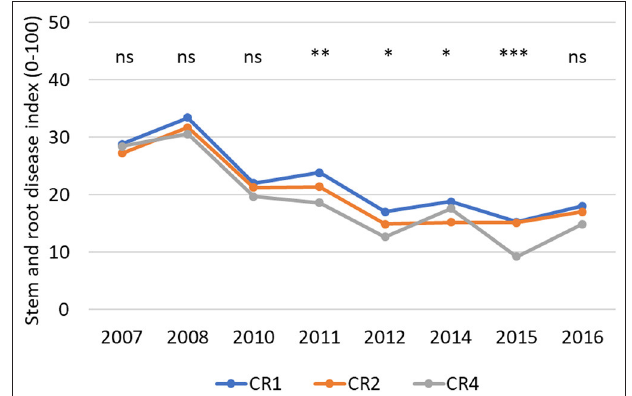
FIGURE 4 | The average stem and root disease index (0–100) in spring wheat in different years and crop rotations. CR1, wheat monoculture; CR2, wheat every 2nd year; CR4, wheat every 4th year. Statistically significant differences: ns = not significant, * p < 0.05, ** p < 0.01, *** p <